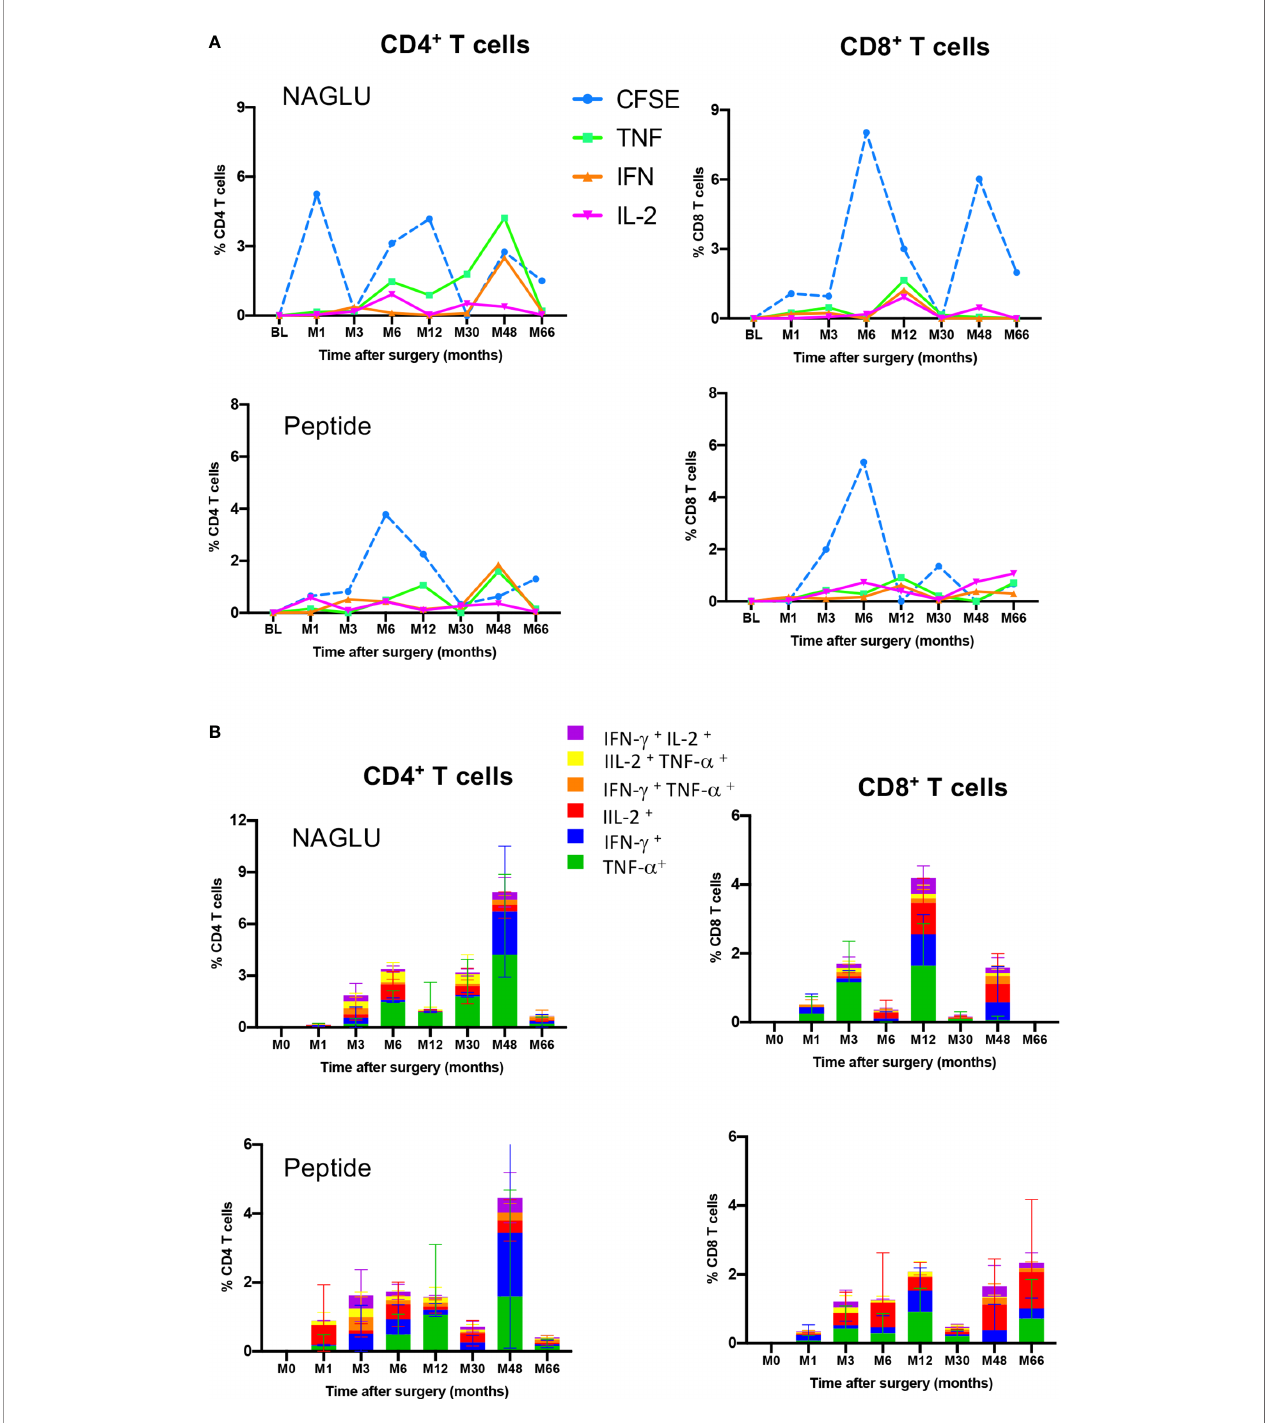
FIGURE 5 | Functional pro fi les of NAGLU-speci fi c circulating CD4 + and CD8 + T cells. (A) Overlay of ex-vivo proliferation and TNF- a , IFN- g or IL-2 expression by CD4 + and CD8 + T cells after exposure of patients ’ PBMCs to NAGLU (0.5 m g/ml) or peptide (1 m g/ml) measured at baseline (BL) and 1, 3, 6, 12, 30, 48 and 66 months after surgery. Mean percentage of NAGLU-speci fi c CFSE low cells or cytokine-expressing cells within CD4 + or CD8 + T cells is plotted for each time point. (B) CD4 + and CD8 + T-cell polyfunctionality analysis after whole blood stimulation for 6 h with NAGLU (0.5 m g/ml) or peptide (1 m g/ml). Bar charts represent the proportion of NAGLU-speci fi c CD4 + or CD8 + T-cells displaying each particular cytokine or combination of cytokines at indicated time points of the follow-up. Data are presented as mean ± SD of speci fi c responses from the four